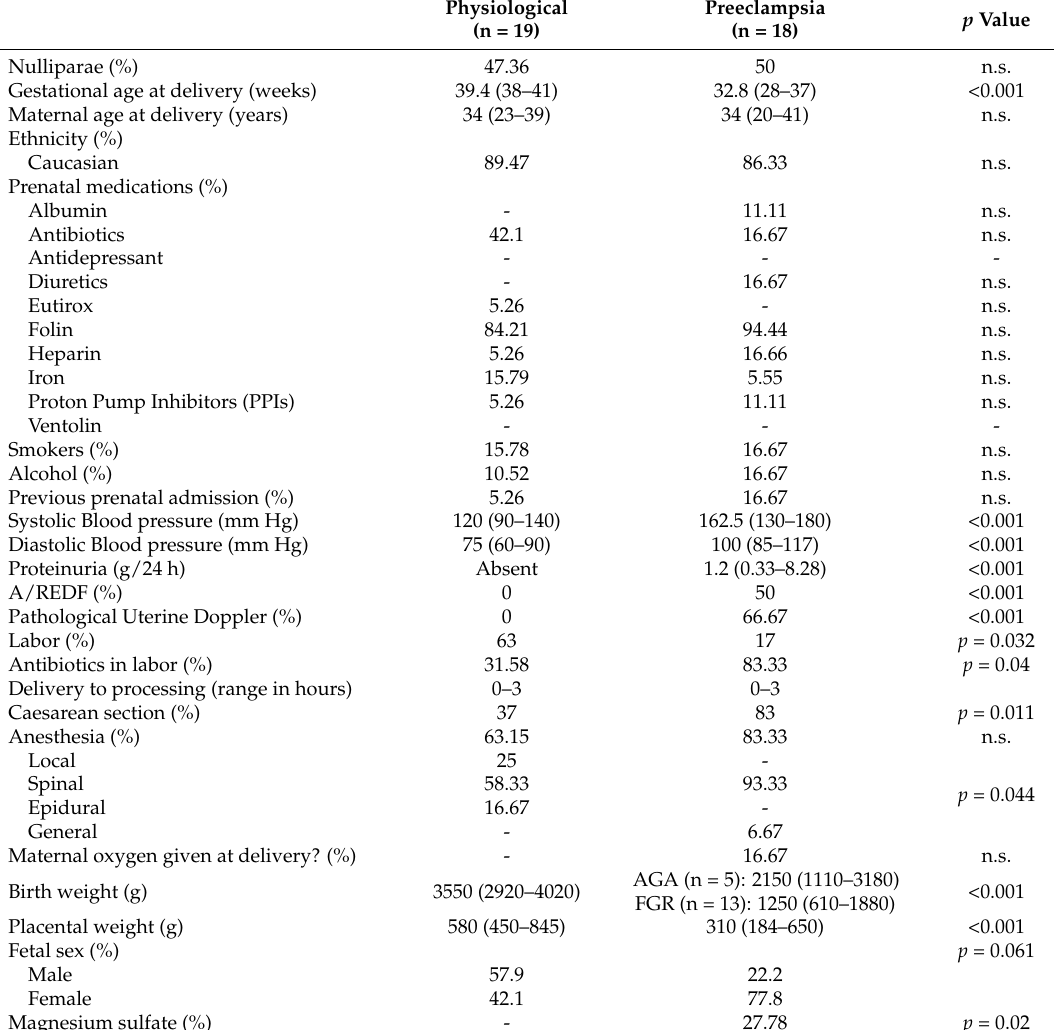
Table 1. Clinical features of the study population. Values are expressed as median (range)